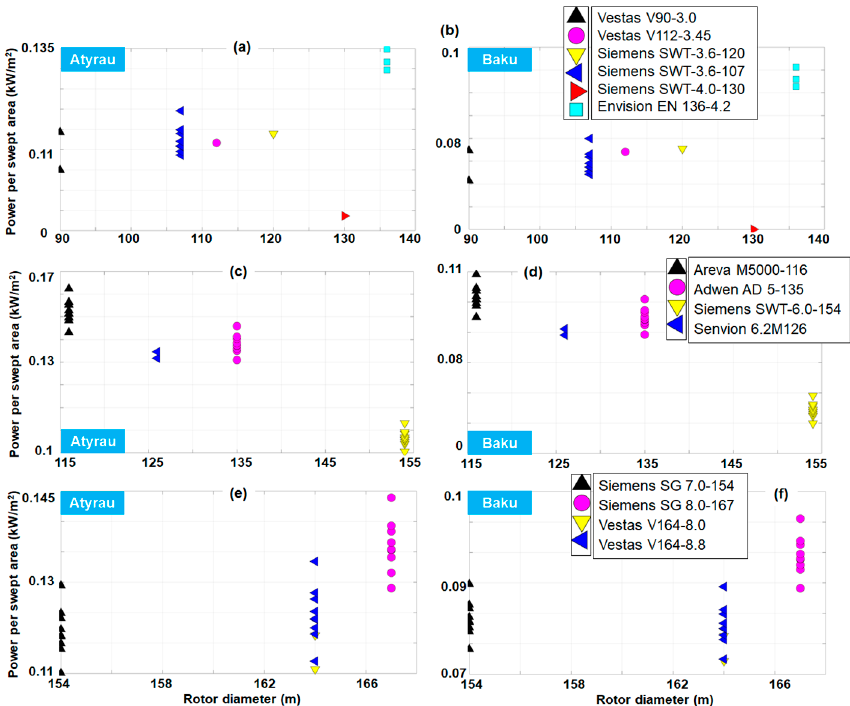
Figure 12. The classification of the wind turbines selected for the sites Atyrau and Baku, taking into account the power output per swept area. The results are grouped as follows: ( a ) and ( b ) small (3–4.2 MW); ( c ) and ( d ) medium (5–6.2 MW); ( e ) and ( f ) large (7–8.8 MW).